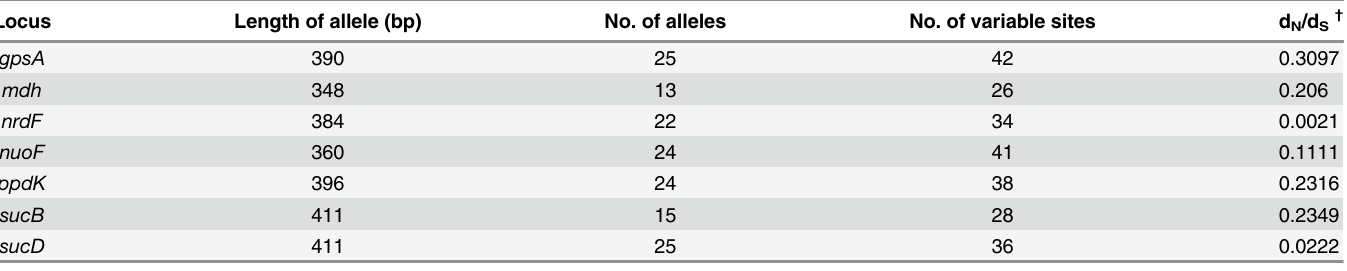
Table 4. The estimation selection in 7 housekeeping gene using the non-synonymous to synonymous amino acid substitution ratio (dN/dS) in this study. Locus Length of allele (bp) No. of alleles No. of variable sites d N /d S †